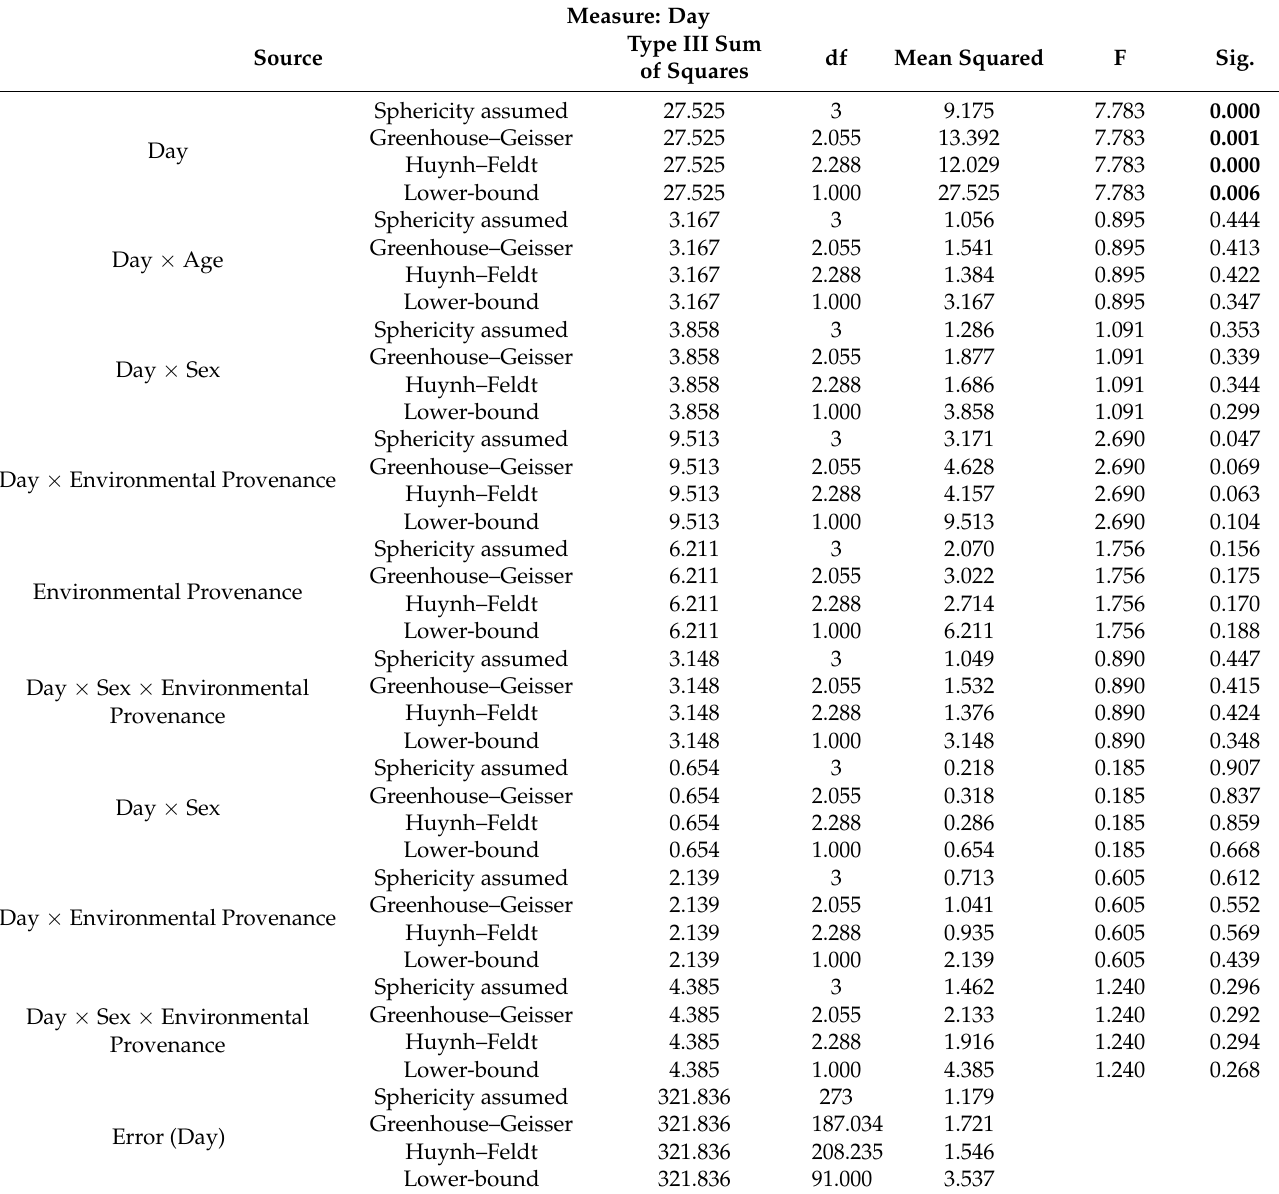
Table 2. Within-Group Effects (repeated measures or intra-group